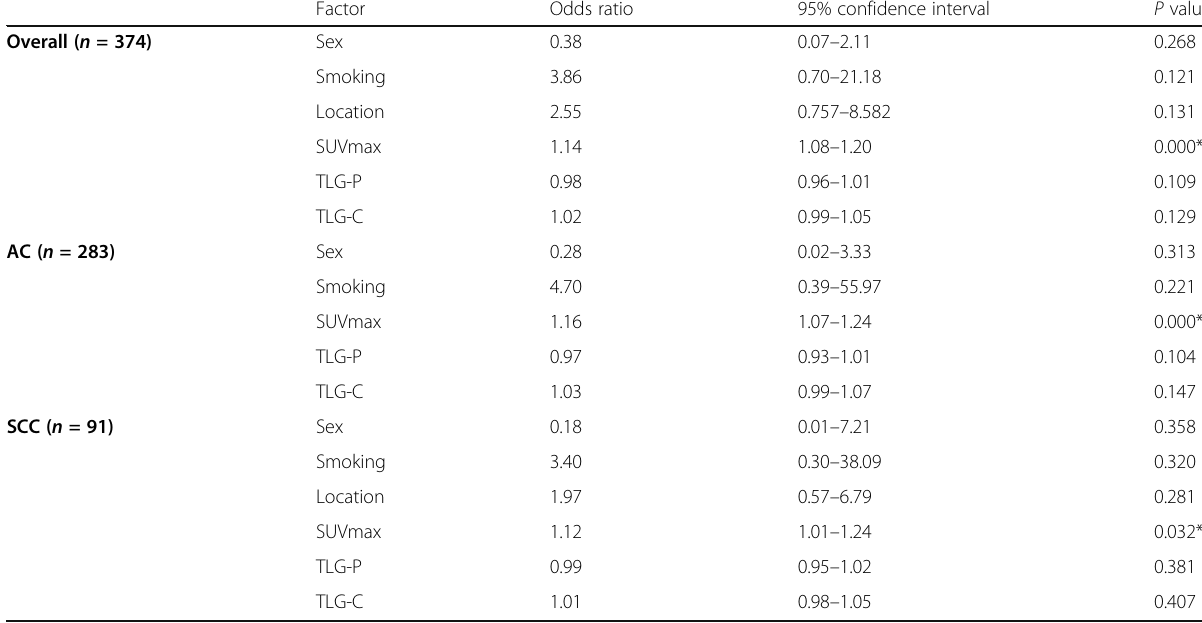
Table 2 Multivariate analysis of the relationship between PD-L1 expression and selected factors which have significance via univariate analysis by logistic regression SUVmax as an independent predictor of PD-L1 expression by multivariate analysis Factor Odds ratio 95% confidence